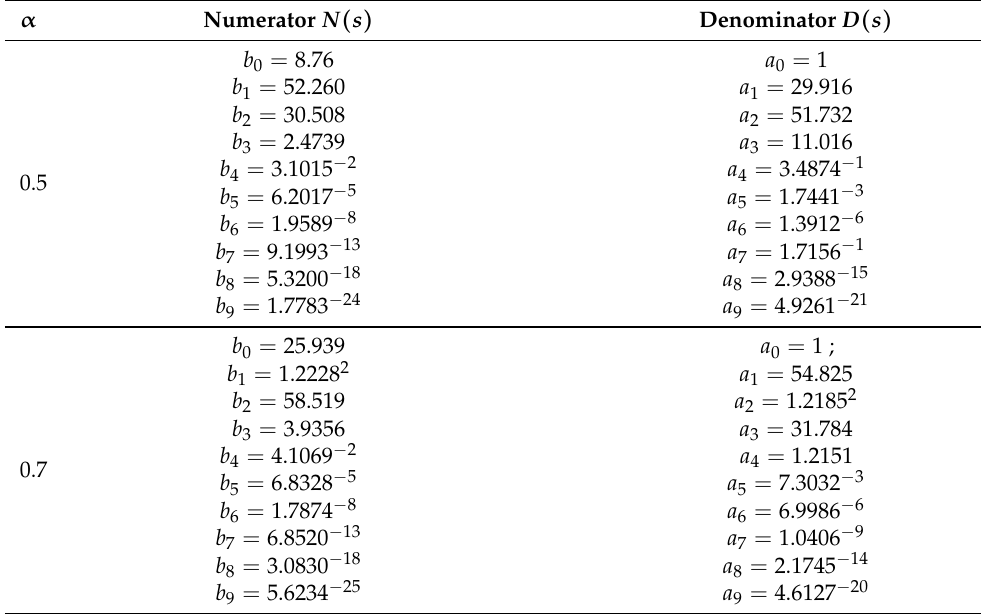
Table 3. Coefficients of numerator and denominator of the ninth-order Matsuda